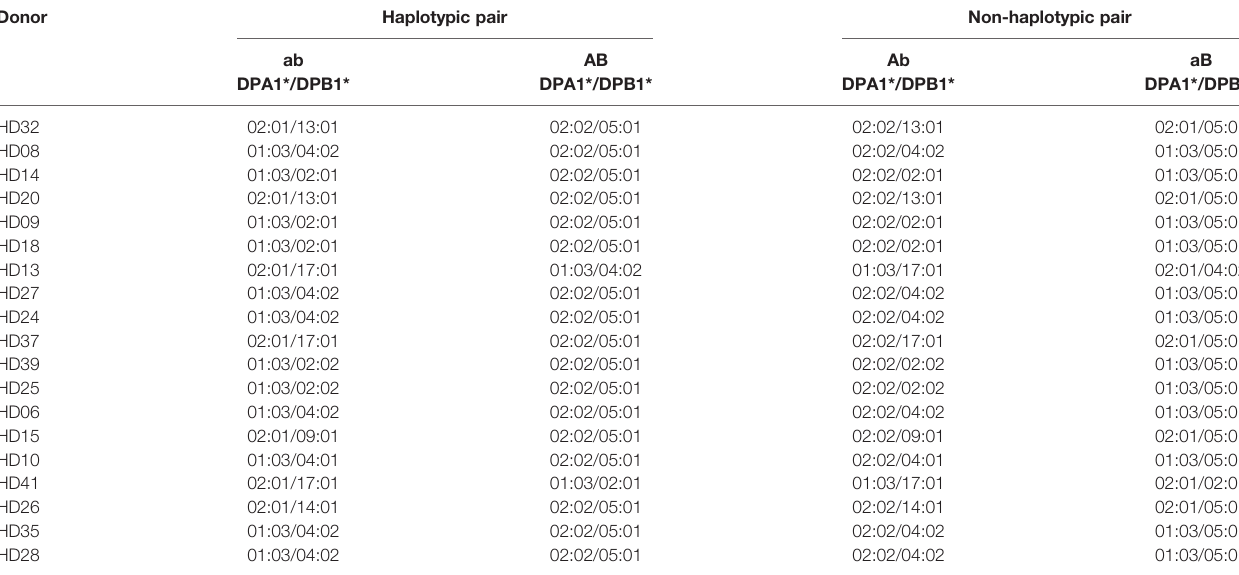
TABLE 2 | Four HLA-DP combinations in 19 double heterozygous